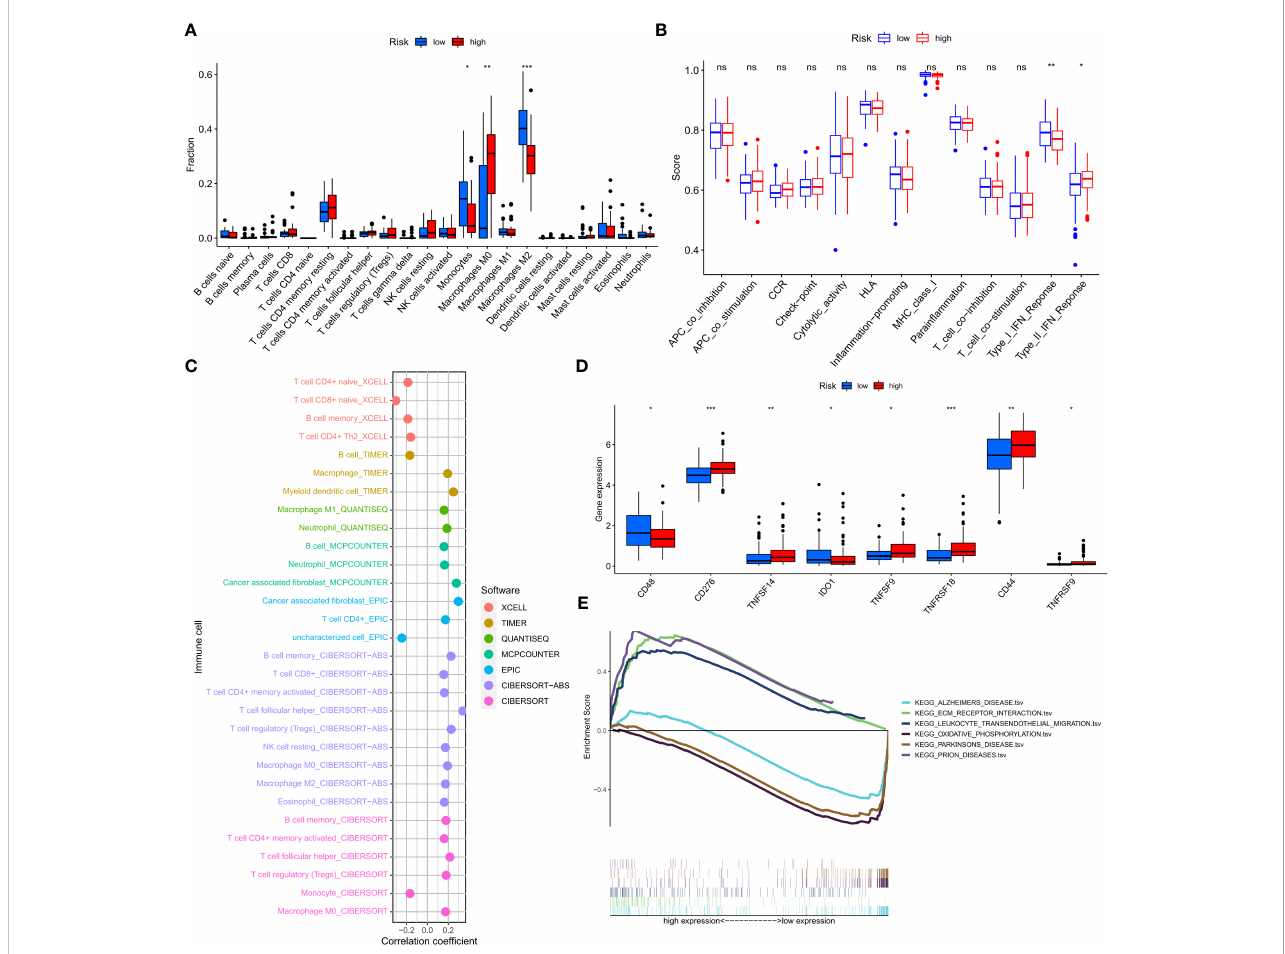
FIGURE 9 Prediction of the tumor microenvironment and immune cell in fi ltration by the 7-NFRGs risk score. (A) Differences in immune cell in fi ltration levels between high and low-risk groups. (B) Differences in immune function between high and low-risk groups. (C) Immune cell bubble map. (D) Differences in immune checkpoint between high- and low-risk groups. (E) GSEA analysis focusing on the differential enrichment of KEGG pathways. *P < 0.05, **P < 0.01, ***P < 0.001, ns ≥